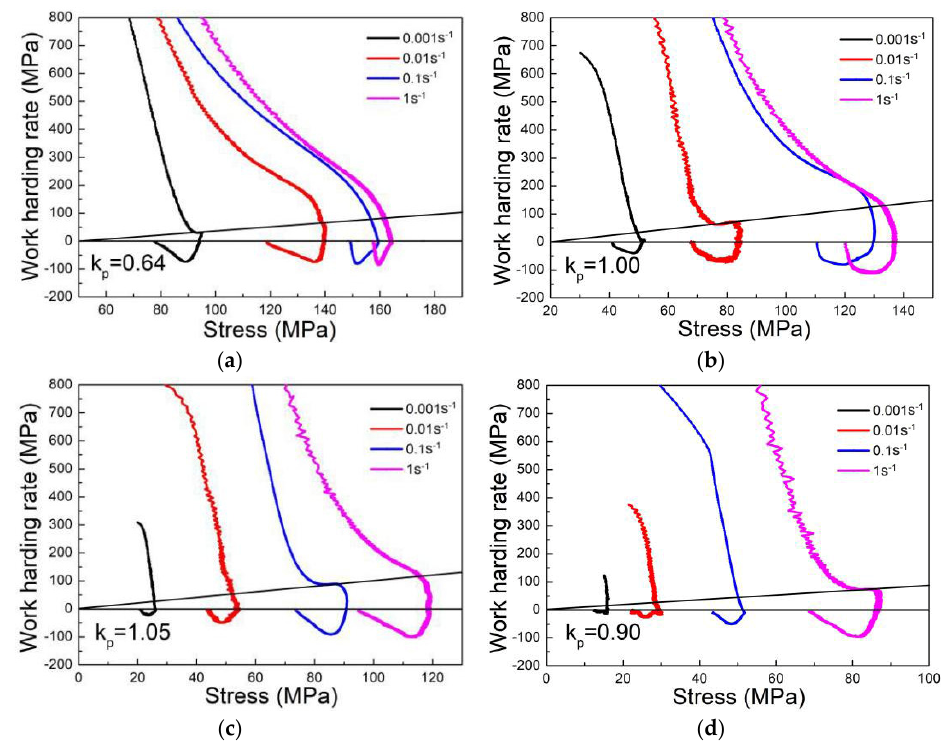
Figure 10. Variation of the work-hardening rate θ with flow stress σ for MZC at different temperatures: ( a ) 523 K; ( b ) 573 K; ( c ) 623 K and ( d ) 673 K.